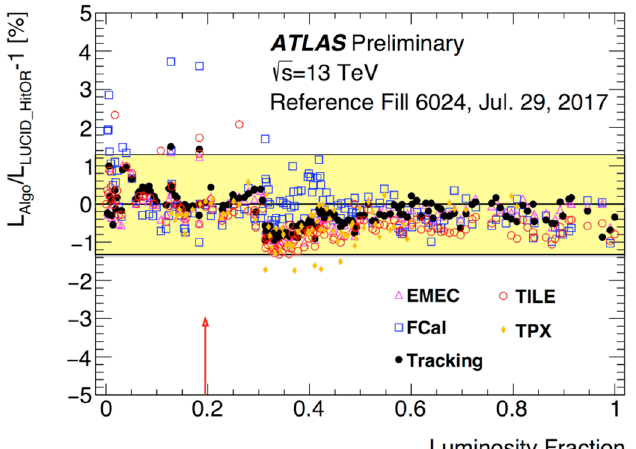
Fig. 1. Fractional differences in run-integrated luminosity between the LUCID BiHitOR algorithm and the TPX3, track-counting, EMEC, FCal, and TILE measurements, plotted as a function of the cumulative delivered luminosity normalised to the 2017 total. The luminosity measurements from the other detectors have been normalised to that of LUCID in the reference run indicated 1 . 3 % long-term stability uncertainty is shown by the arrow. The assigned ± by the yellow band